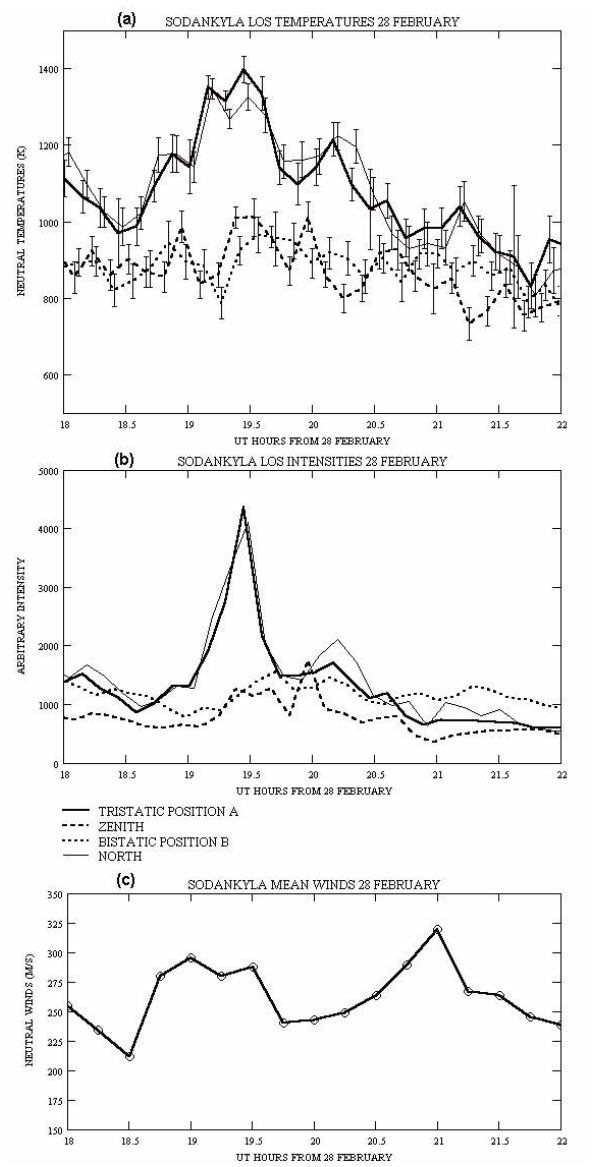
Fig. 10. (a) A close-up of the Sodankyl¨a thermospheric tempera- ture gradients from 18:00–22:00 UT on the night of 28 February– 01March 2003. (b) The Sodankyl¨a 630-nm intensities over the same period. (c) The average magnitude of the horizontal wind component calculated from the 4 cardinal directions from the So- dankyl¨a FPI over the same period.